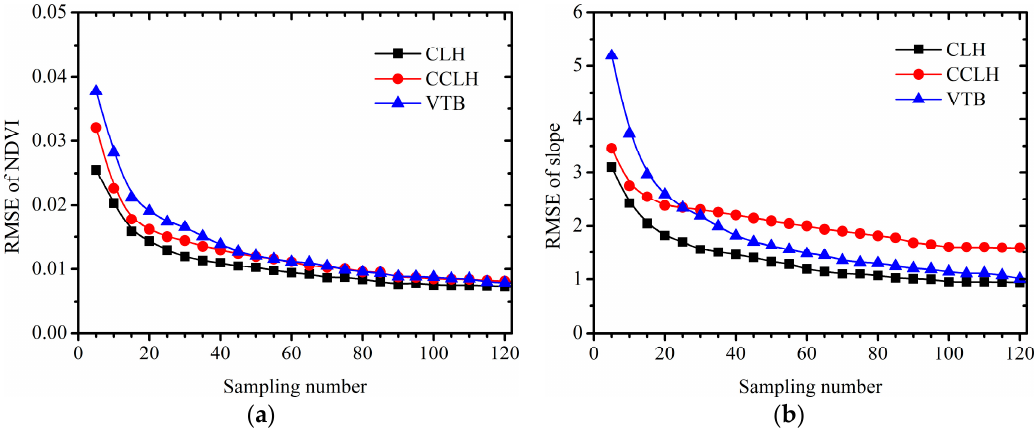
Figure 2. Changes in RMSEs of NDVI ( a ) and slope ( b ) from vegetation type-based (VTB), cost-constrained (CSS) and conditioned Latin hypercube without cost constraints (CLH) sampling strategies, respectively.